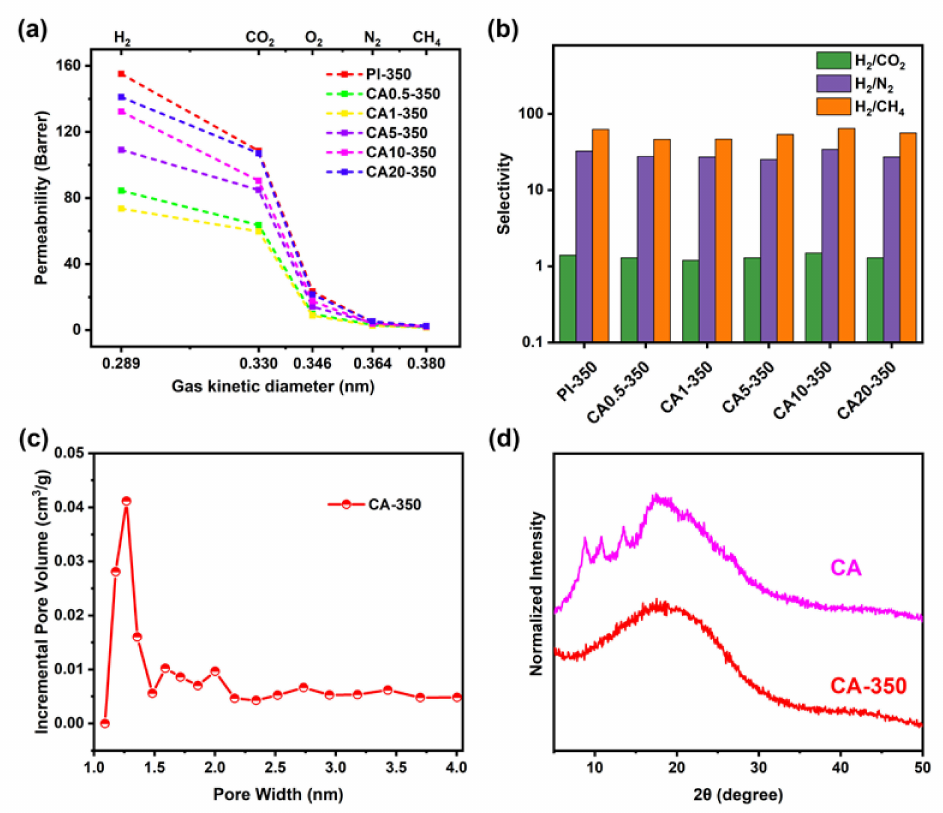
Figure 9. Gas permeability ( a ) and selectivity ( b ) of composite membranes after heat treatment at 350 ◦ C; ( c ) pore size distribution curve based on N 2 sorption and ( d ) WAXD